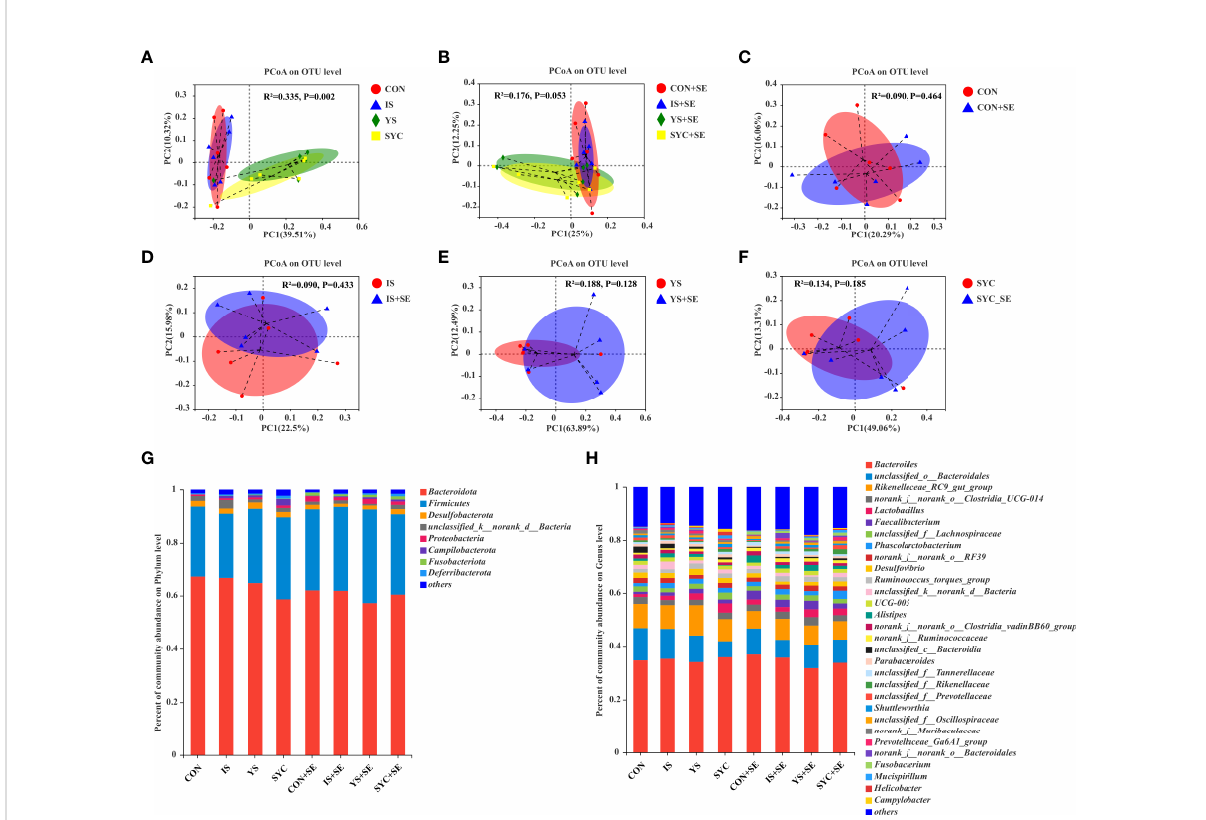
FIGURE 9 Effects of dietary supplementation with different Se sources on the principal coordinate analysis (PCoA) and the relative abundance in the cecal microbiota of laying hens challenged with S. Enteritidis . CON, basal diet; IS, sodium selenite; YS, yeast selenium; SYC, selenium-enriched yeast culture; CON+SE, IS+SE, YS+SE, and SYC+SE mean CON, IS, YS, and SYC challenged with S. Enteritidis , respectively. (A) PCoA in the CON, IS, YS, and SYC groups. (B) PCoA in the CON+SE, IS+SE, YS+SE, and SYC+SE groups. (C) PCoA in the CON and CON+SE groups. (D) PCoA in the IS and IS+SE groups. (E) PCoA in the YS and YS+SE groups. (F) PCoA in the SYC and SYC+SE groups. (G) Relative abundance of gut microbiota at the phylum level. (H) Relative abundance of gut microbiota at the genus